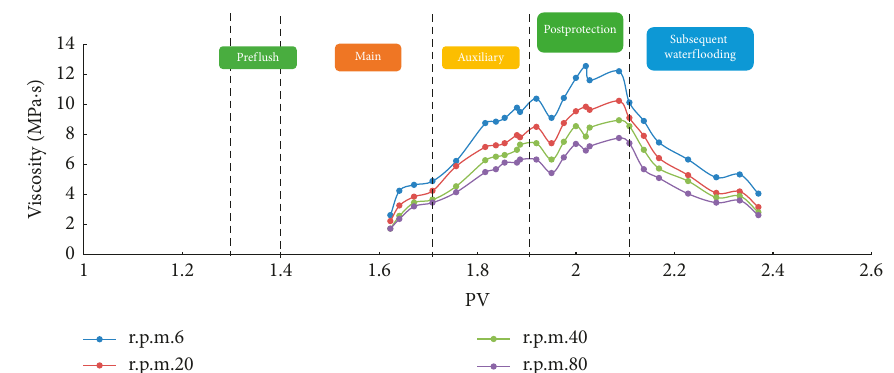
Figure 9: Viscosity change of produced liquid.